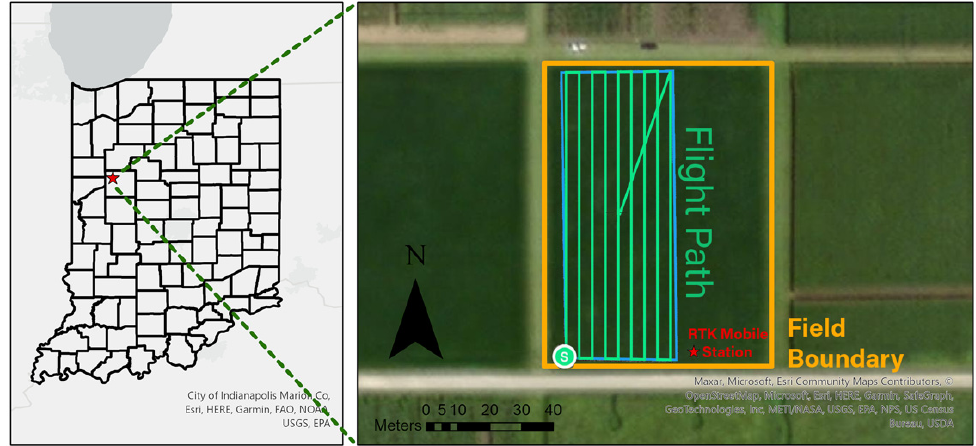
Figure 1. Field 21B located at Purdue University’s ACRE farm and UAS flight path for data collection.